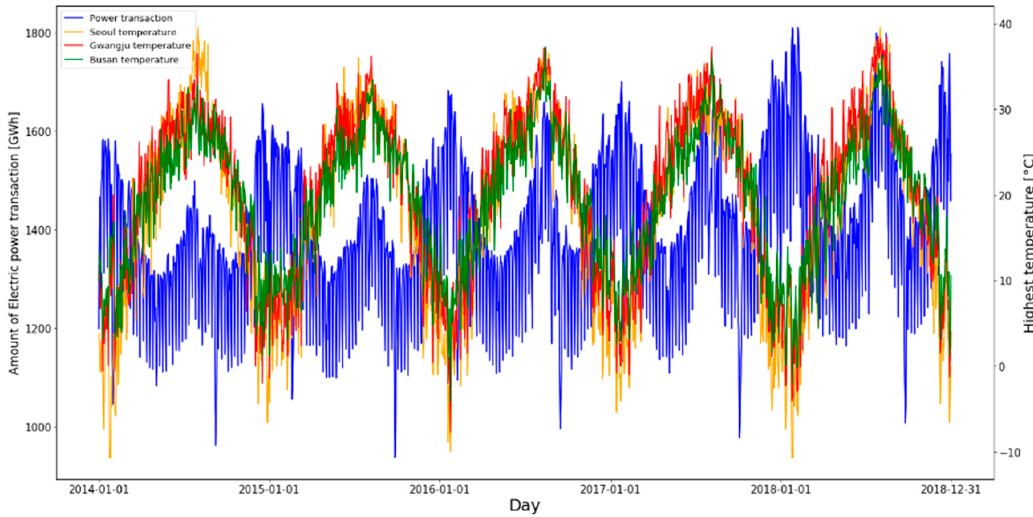
Figure 6. Amount of EPT in South Korea and the highest temperature in Seoul.